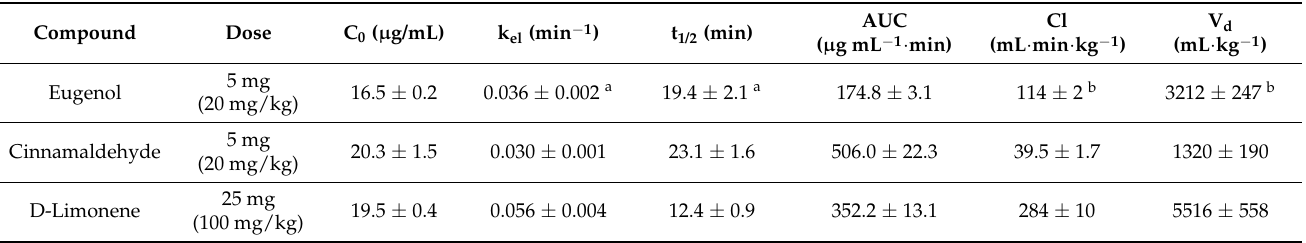
Figure 1. Elimination profile of eugenol after 5 mg intravenous infusion to rats (20 mg/kg). Data are expressed as the mean ± SE of four independent experiments. The elimination showed a relatively high rate within 5 min from the end of infusion; then, from 10 min after the end of infusion, it followed an apparent first order kinetics confirmed by the semilogarithmic plot reported in the inset ( n = 6, r = 0.982, p < 0.001). The terminal half-life of eugenol was calculated to be 19.4 ± 2.1 min. Table 1. Pharmacokinetic parameters referred to the bloodstream of eugenol, cinnamaldehyde and D-limonene after intravenous administration to rats. Data are reported as mean ± SE ( n = 4). C 0 : concentration at the end of infusion; k el : pseudo first order kinetic elimination rate constant; t 1/2 : half-life; AUC: area under concentration from the starting time of infusion to infinity; Cl: clearance; V d : volume of distribution.